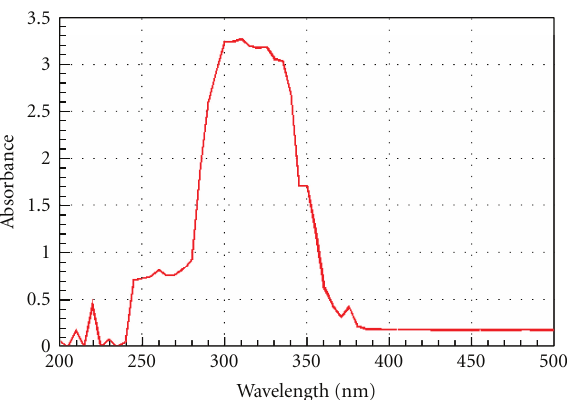
Figure 3: UV absorption spectrum.